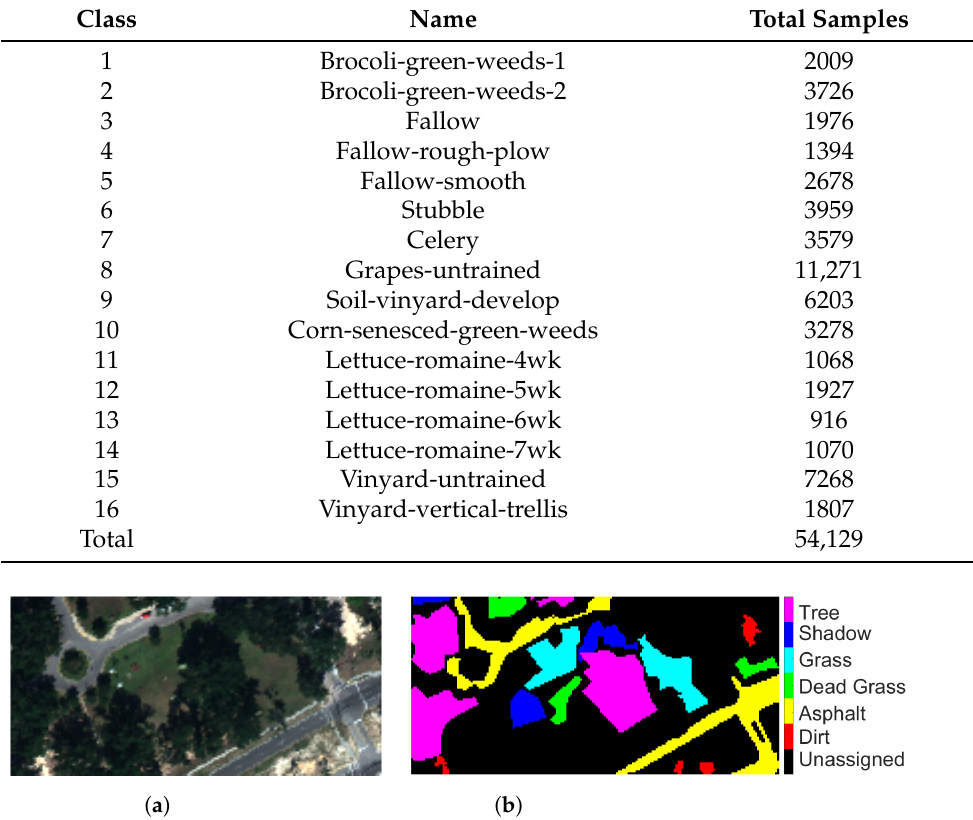
Figure 4. Mississippi Gulfport ( a ) true-color composite; ( b ) reference class